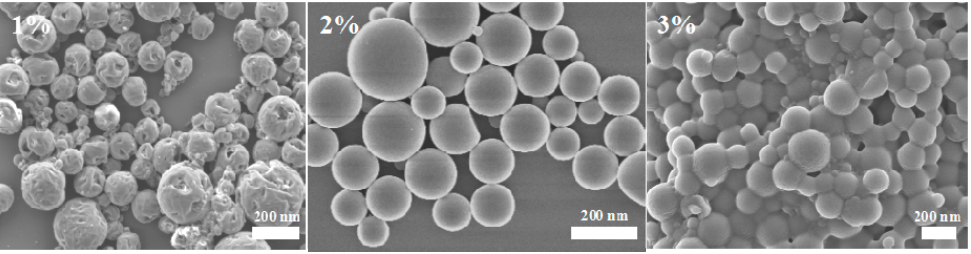
Figure 2. SEM micrographs of PLA nanoparticles prepared under different PVA concentrations (1%, 2%, and 3%).